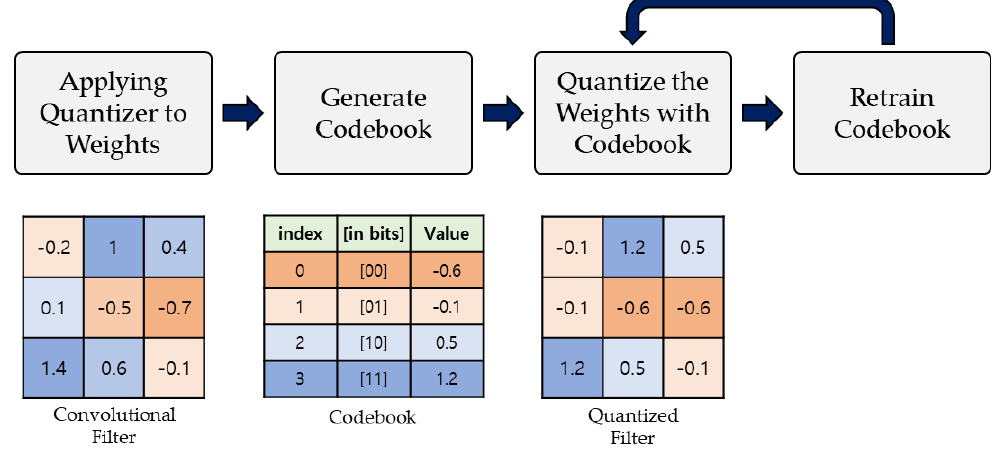
Figure 1. Process of weights quantization in convolutional neural networks.